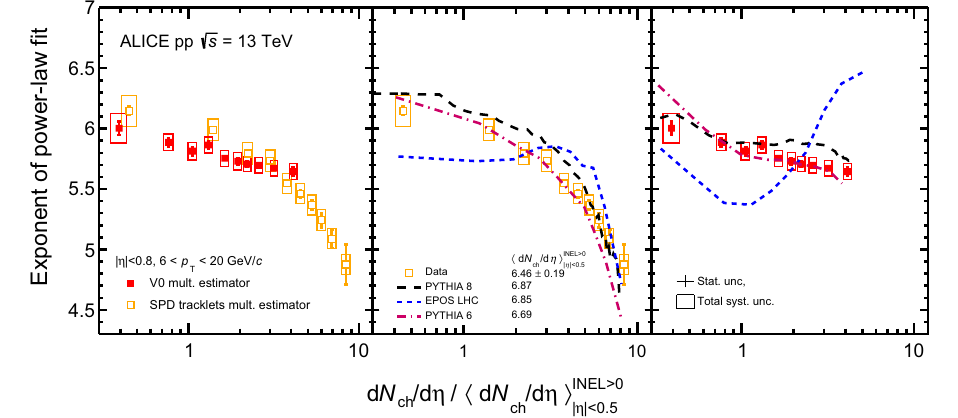
Fig. 5 Evolution of the spectral shape of the transverse momentum distribution as a function of charged-particle multiplicity. The spectral shape is characterized by the exponent of the power-law function which fits the high- p T part ( p T > 6GeV/ c ) of the invariant yields. Results for √ s = 13TeV are shown. A comparison of the two mul- pp collisions at